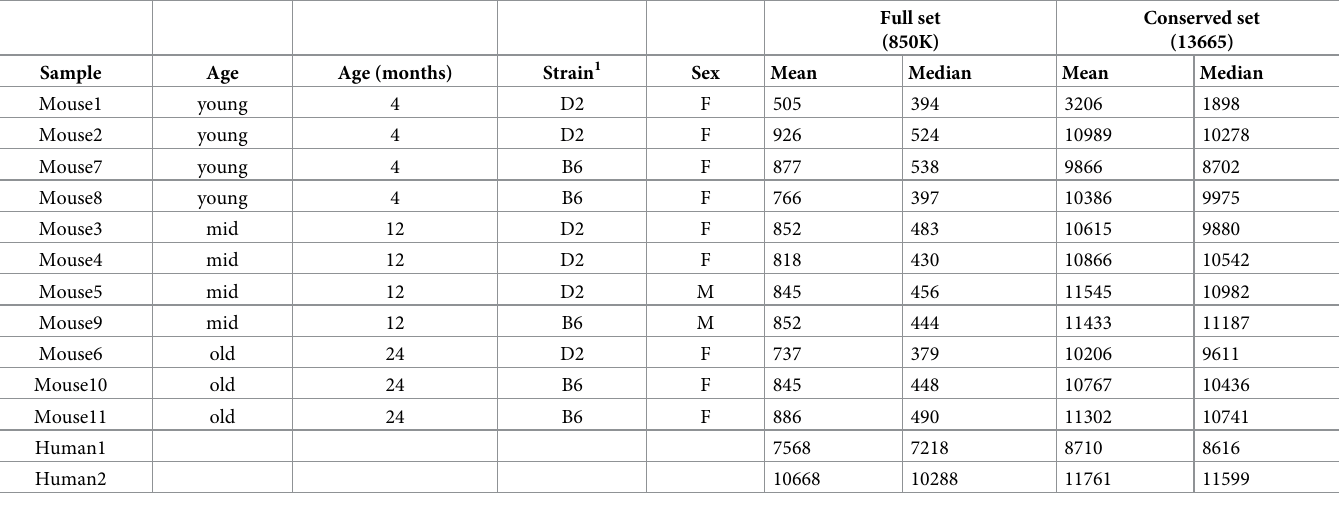
Table 1. Sample details and average methylation signal